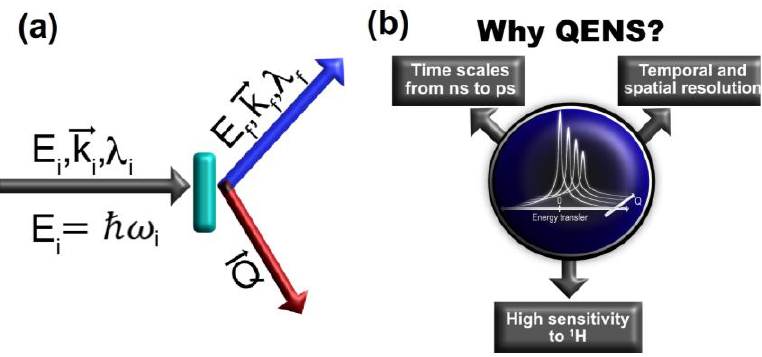
Figure 1. ( a ) Typical scattering triangle showing incoming neutrons with incident energy E i , wave- length λ i , and wave vector 𝑘 𝑖 ⃗⃗⃗⃗ interacting with the sample and assuming final energy E f , wavelength λ f , and wave vector 𝑘 𝑓 ⃗⃗⃗⃗⃗ . The momentum transfer 𝑄⃗⃗ is defined as the change in wave vector ( 𝑄⃗⃗ = 𝑘 𝑖 ⃗⃗⃗⃗ − 𝑘 𝑓 ⃗⃗⃗⃗⃗) ; ( b ) summary of the main features of the QENS technique. These are explained in detail in the text.